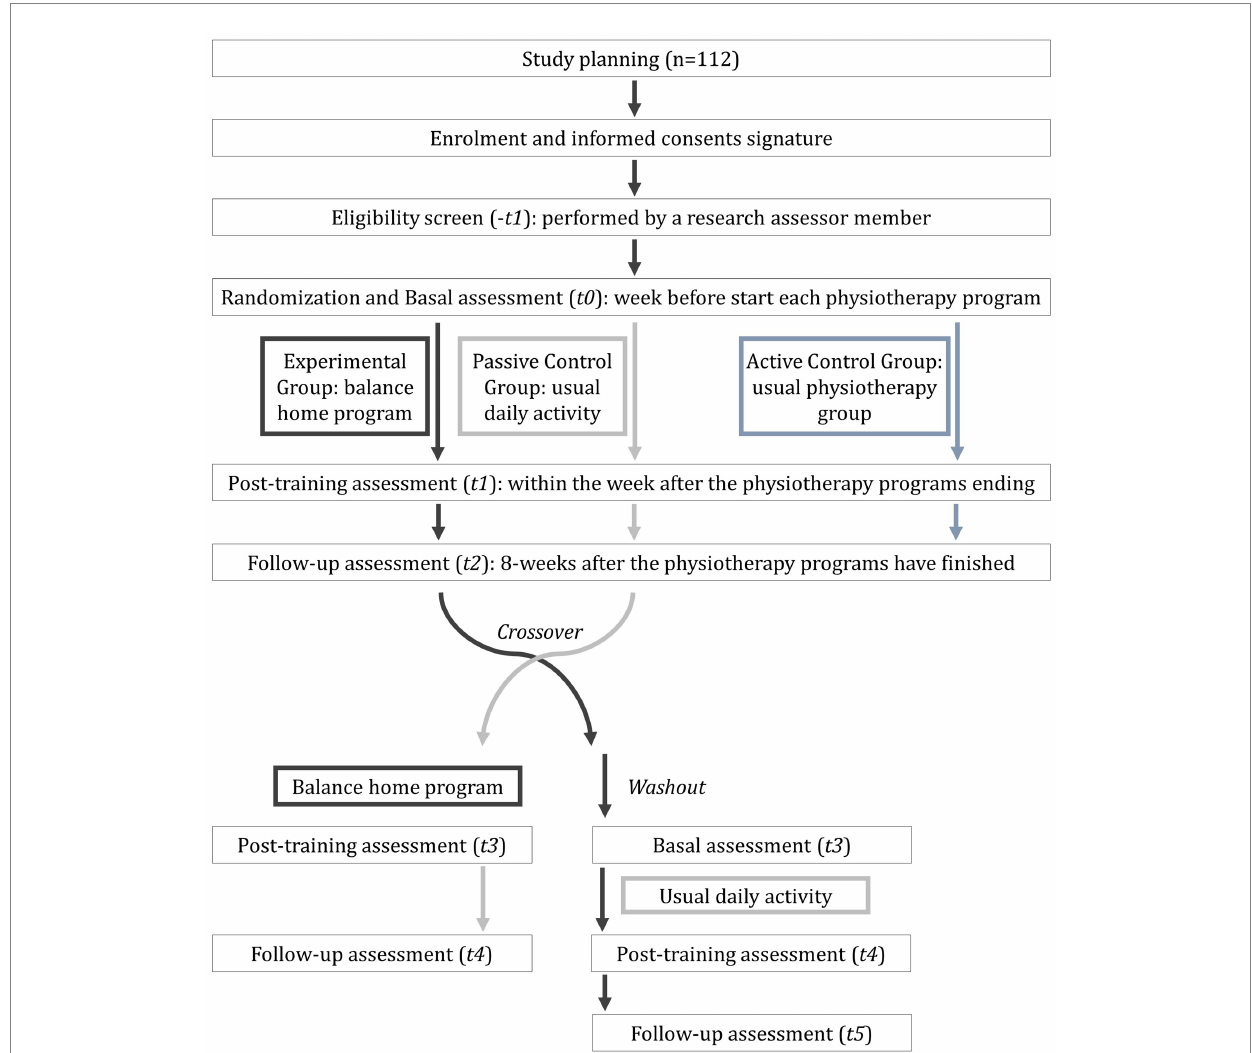
FIGURE 1 Schedule of enrolment, interventions, and assessments of balanceHOME randomized control trial